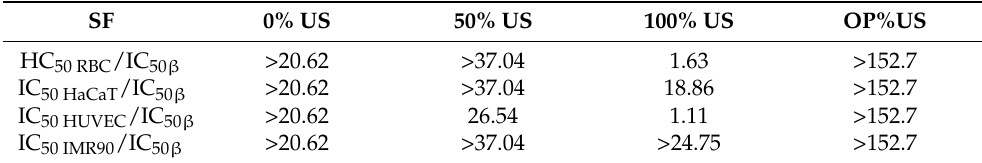
Table 3. Safety factor (SF) of 0, 50, 100% US, and OP%US based on β -carotene bleaching